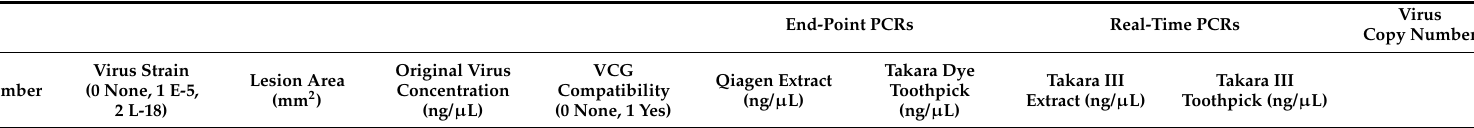
Table 4. Correlation results among all the tested parameters in assay II, using